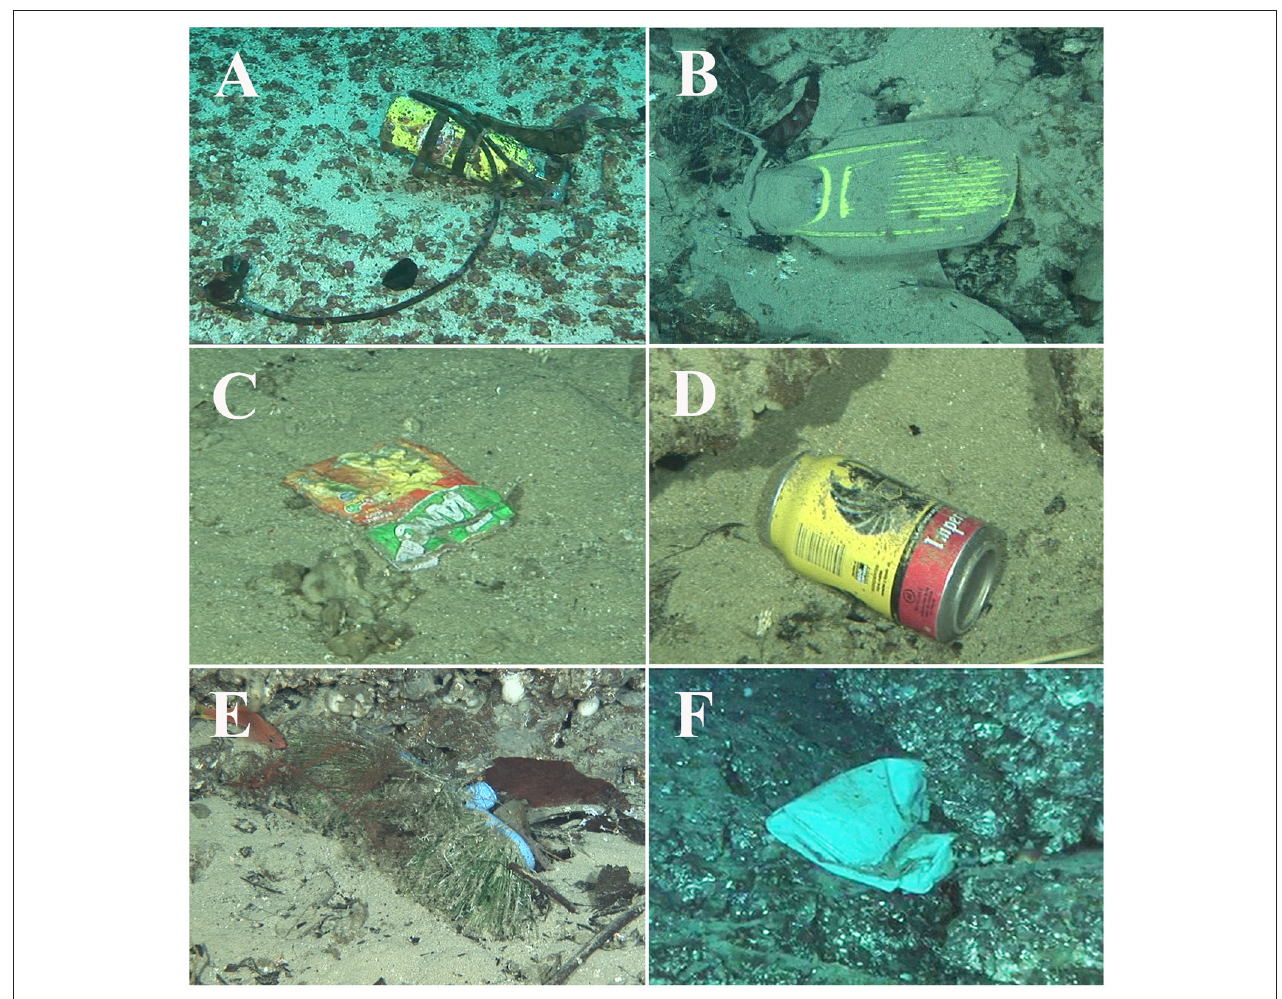
FIGURE 3 | Scuba gear and other debris deposited in deep sediments of Isla del Coco National Park. (A) Scuba tank, 300m depth. (B) Fin, 320m depth. (C) Product wrapping, 210m depth. (D) Beer can, 220m depth. (E) Broom, 200m depth. (F) Plastic bag, 240m depth.